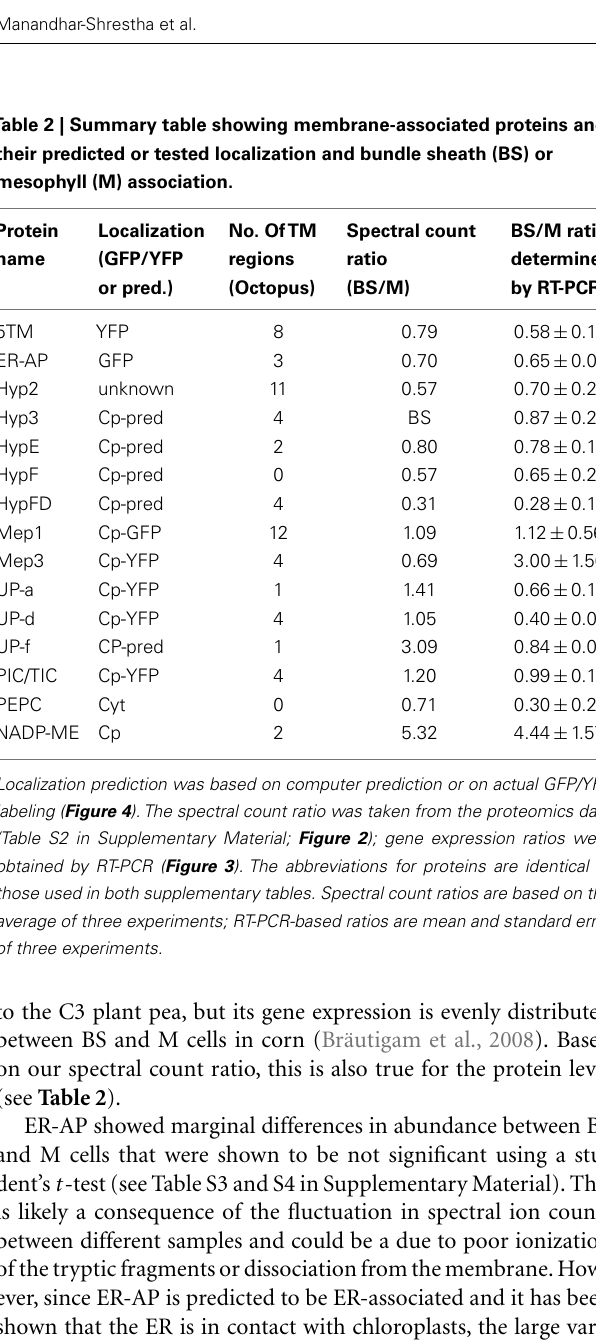
Table 2 | Summary table showing membrane-associated proteins and their predicted or tested localization and bundle sheath (BS) or mesophyll (M) association.